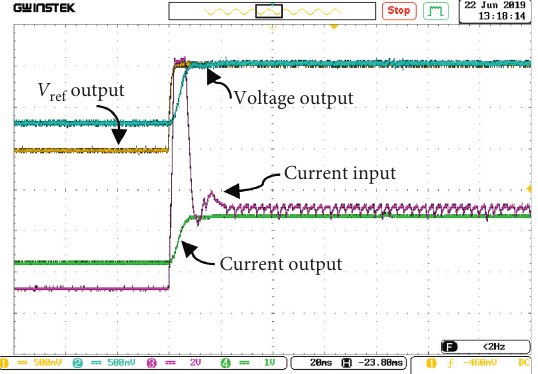
Figure 30: Result of maintaining voltage stability and current while changing load using a PI controller with PSO search. Table 4: System response by the PI controller at